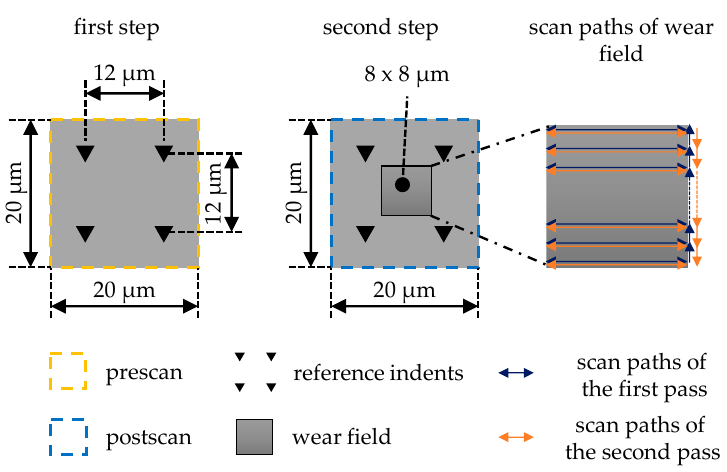
Figure 3. Schematic representation of the procedure of the extended wear test. For the nano wear test, a cube corner indenter made of diamond with a tip radius less than 50 nm was used. The cube corner is a very sharp-edged indenter, which can cause wear even on very hard materials. Another reason for using the cube corner indenter is that it affects less volume during indentation than, for example, the Berkovich or a conical indenter. Thus, the reference indents can be positioned close to the wear field without influencing the wear behavior of the coating. Furthermore, the penetration depth of the cube corner indenter is significantly greater than that of the Berkovich or conical indenter, even at moderate loads, so that it is much easier to detect the reference indents as the deepest points later on. A force of 8000 µ N was used for the reference indents in the Mo-coating and a force of 4000 µ N for the MoO 3 -coating. The lower force for the MoO 3 is due to the fact that the greater loads resulted in a significantly greater pile-up, which in some cases came very close to the wear field. Since a sufficient penetration depth was achieved with 4000 µ N and at the same time the pile-up could be reduced, the force was used for the reference indents. Table 1 lists the settings for the pre-scan, the post-scan, and the wear field. The scan rate determines the speed of the scanned image, and slower scan rates will offer less image distortion while higher scan rates may cause noise or artifacts depending on the specimen. To ensure that the resolution and quality of pre-scan and post-scan were as high as possible, the scan rate was reduced to 0.5 Hz, and a minimum scanning force of 2 μ N was set so that no material was removed during the scans. Beake et al. investigated the influence of the number of lines on the scan quality and showed that the scan quality could be significantly increased with an increasing number of lines [16]. Therefore, the number of lines was set to 512, as this is a good compromise between scan quality and scan time. For the wear field, the scan rate was set as constant to 1 Hz. Koinkar et al. also found that the scan rate did not have a large influence on the wear behavior on the nano level [41], whereas Beake et al. and Degiampietro et al. found an influence of the scan rate on the wear behavior [16,24]. Table 1. Measurement settings for the in ‐ situ SPM for the pre ‐ scan, the post ‐ scan and the wear field. Scans